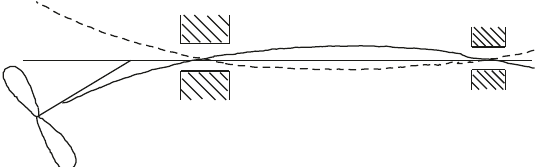
Figure 3: Schematic diagram of shafting whirling